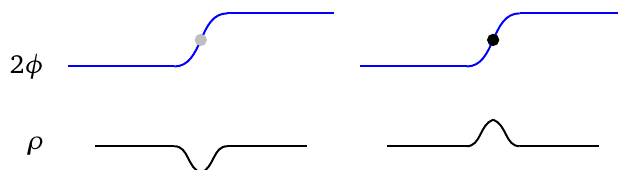
Figure 3: Degenerate domain wall states differ in their charge